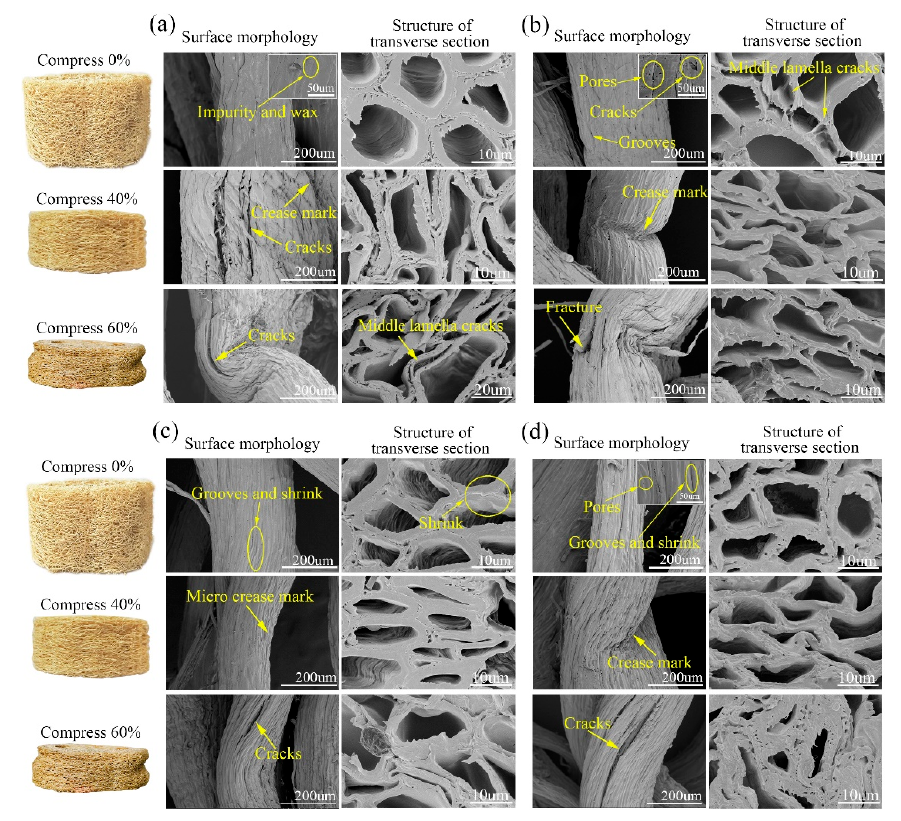
Figure 7. Surface morphology and microstructures of the inner luffa fiber bundles: ( a ) Untreated luffa;